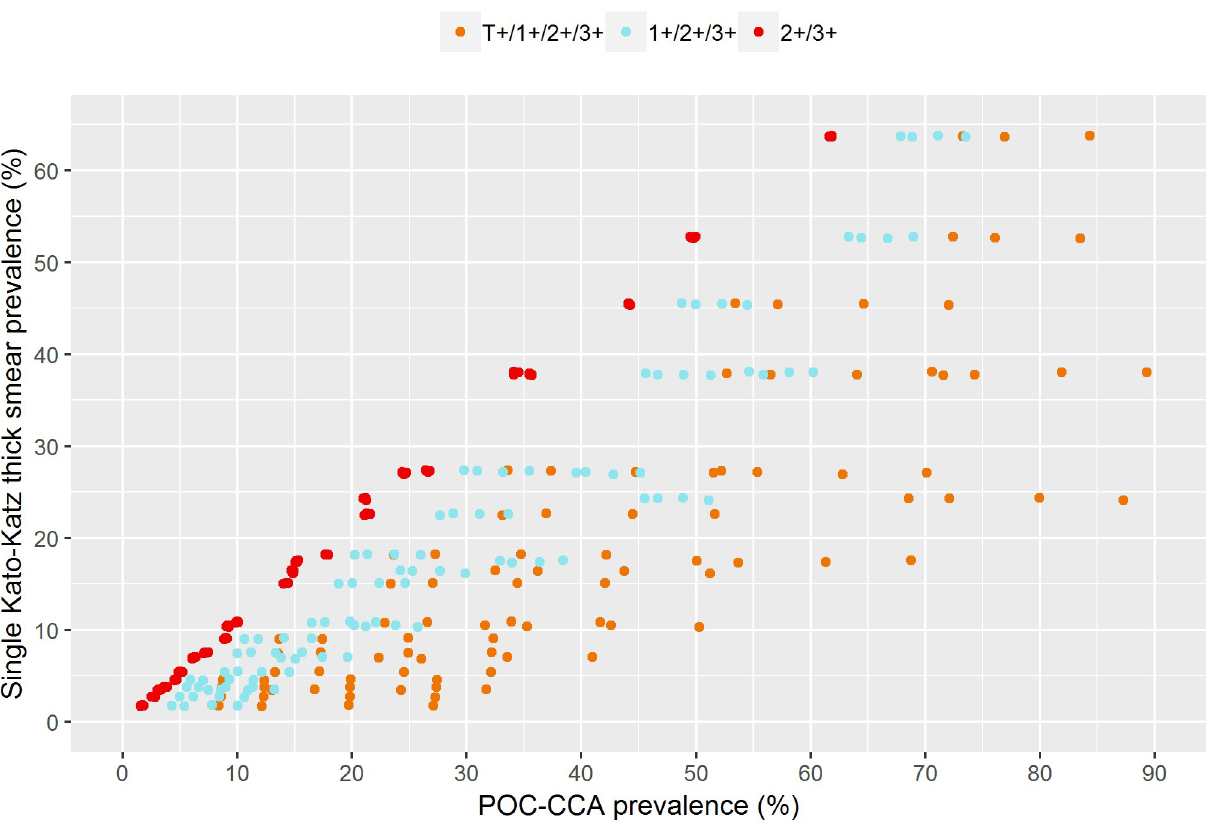
Fig 6. Scatter plot of all results for single slide Kato-Katz from Fig